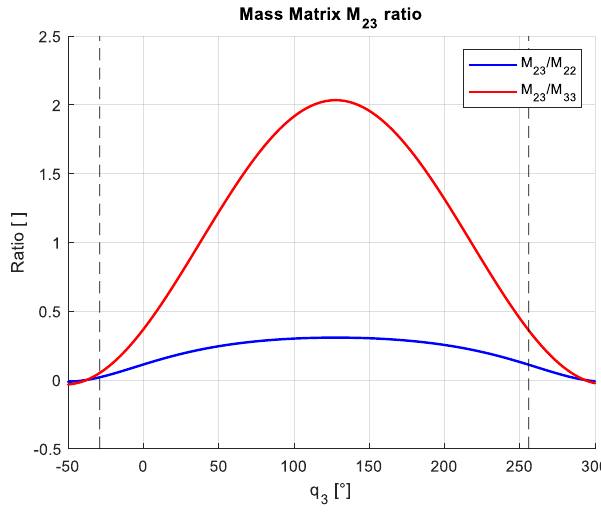
Figure 5. Effect of joint variable 𝑞 3 on inertial cross coupling between J2 and J3. Figure 5. E ff ect of joint variable q 3 on inertial cross coupling between J2 and